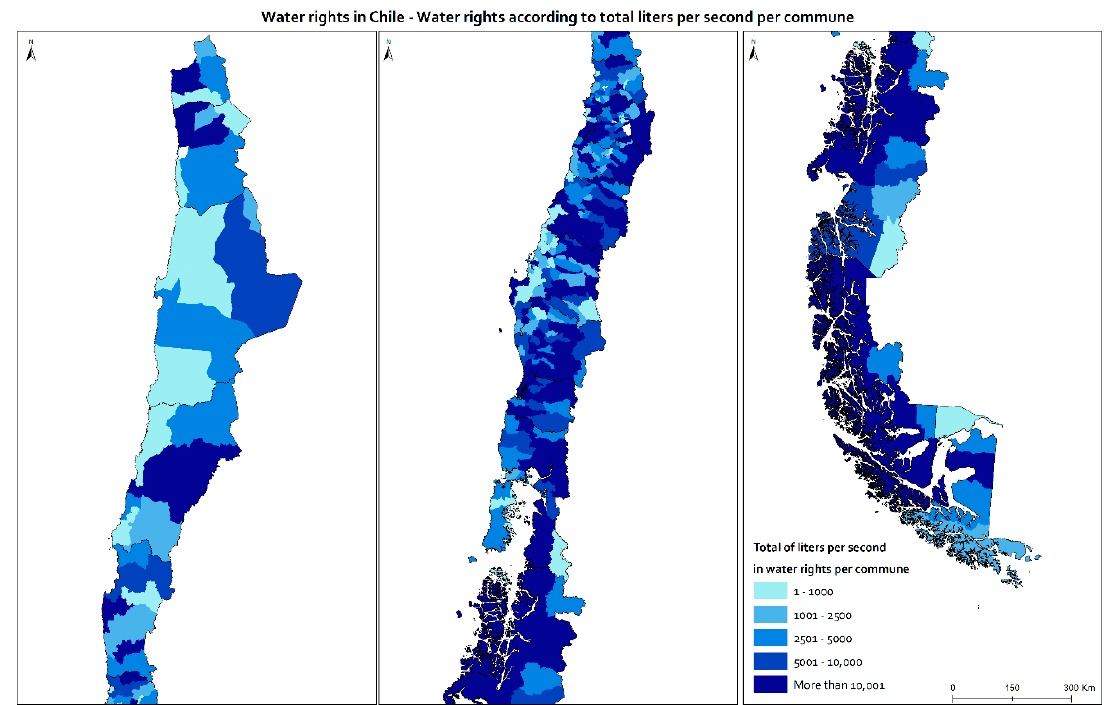
Figure 4. Water rights according to total liters / second per commune. Source: Own elaboration from